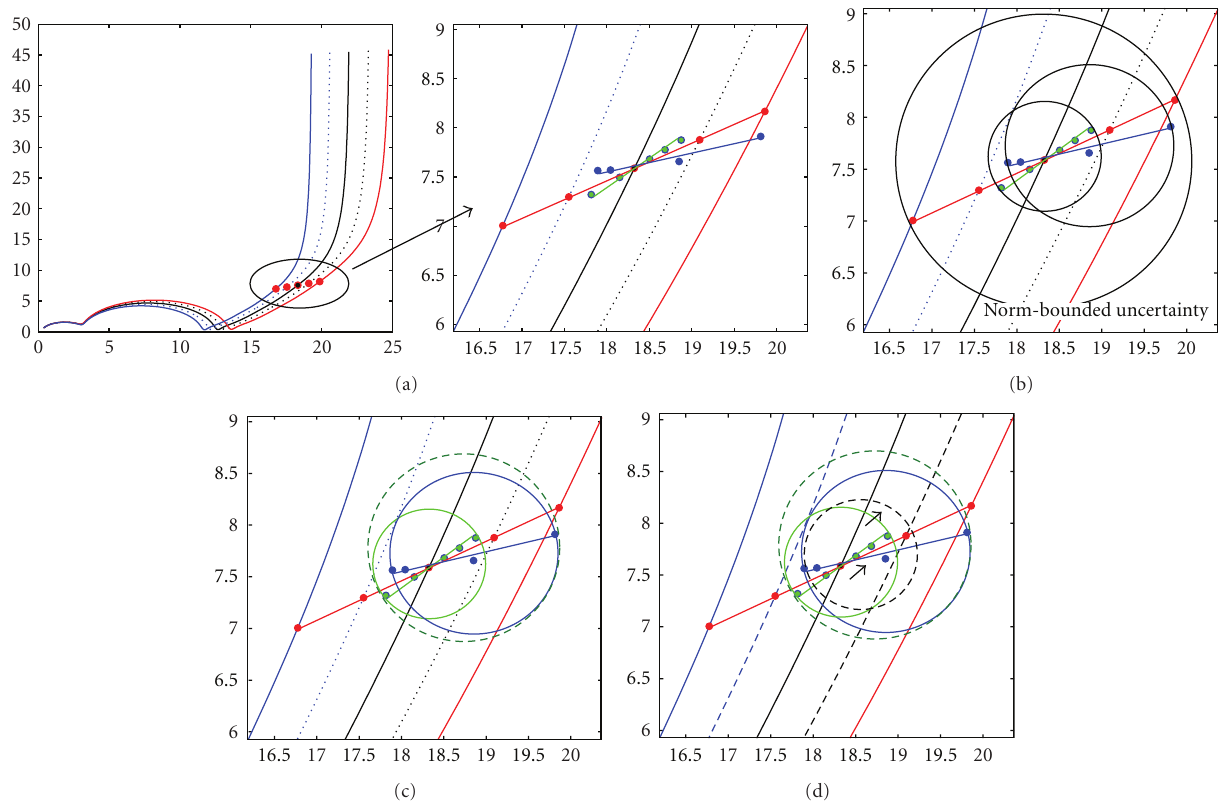
Figure 6: (a) Superimposing sensitivity data from Figures 4 and 5. (b) Construction of the norm-bounded uncertainties for the individual parameters: the smallest disc corresponds to the uncertainty in the cathode thickness, the medium-sized disc to that of the cathode porosity, and the largest to the particle size within the cathode. (c) Determining the overall uncertainty in the impedance response at 1mHz: the dashed circumcircle shows the uncertainty region covering the influence of the variations in the individual parameters. (d) Setting the nominal value for the cathode thickness at 75 µ m instead of 70 µ m moves the individual uncertainty disc from the solid circle shown in (c) to the dotted circle, and the overall uncertainty from the dashed circumcircle to coincide with the individual disc corresponding to that of the porosity